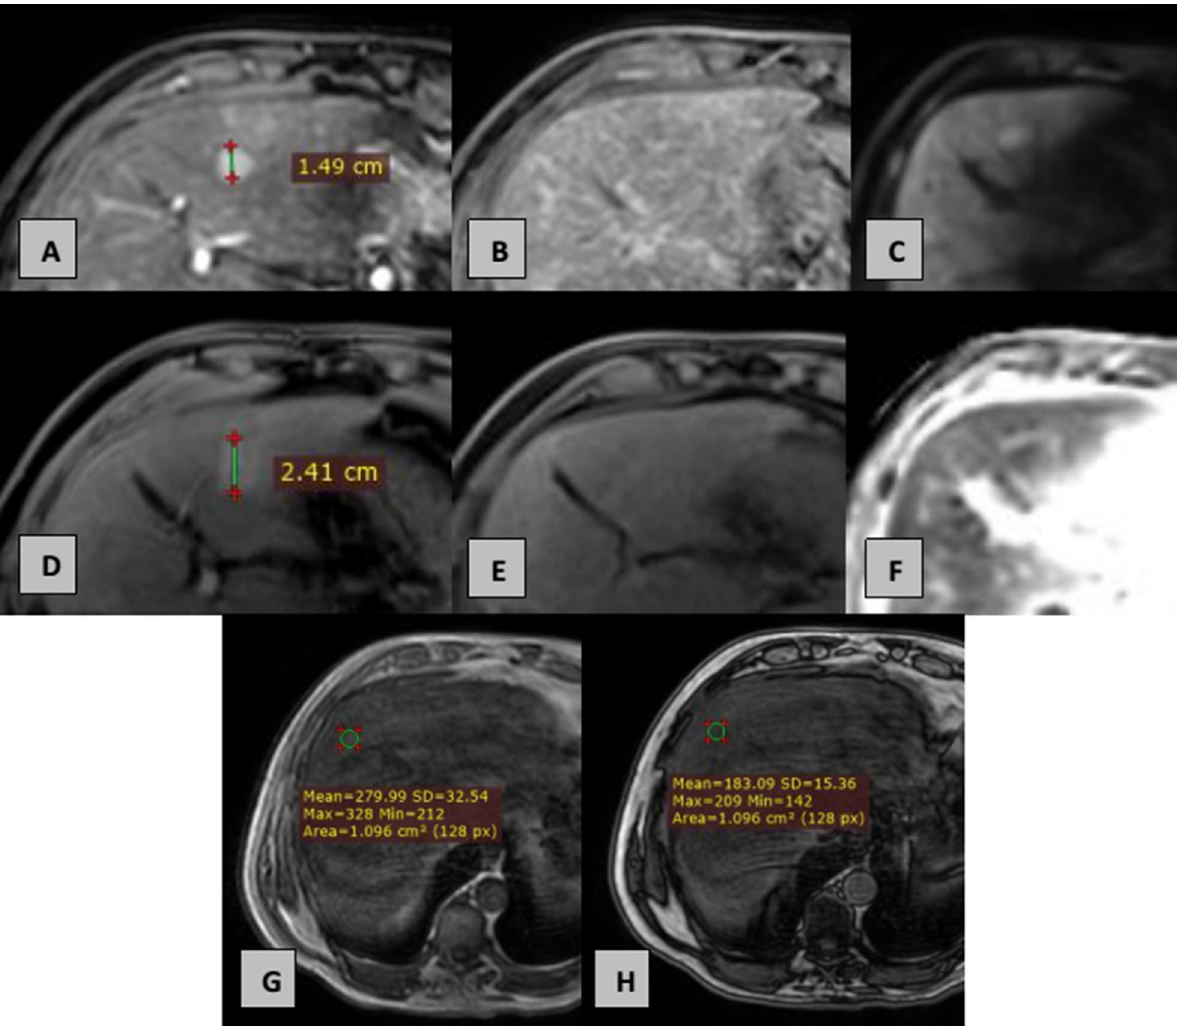
Fig. 3 A 64-year-old male patient with moderate cirrhosis and multiple HCC lesions. A Late arterial; B delayed phase; C diffusion-weighted images, showing a small focal lesion (HCC) at the left lobe segment II with early non-rim APHE and restricted diffusion. D Late arterial, E delayed phase, F ADC image obtained 3 months later showing enlargement of the lesion. G In-phase gradient echo, H opposed phase gradient echo images showing Hepatic fat fraction: 17.2% (moderate steatosis). Major HCC features: Non-rim APHE (late) “Please note the absence of the delayed enhancing capsule in this case.” Ancillary HCC features favoring malignancy: restricted diffusion, subthreshold growth “Unequivocal size increase of a mass, less than threshold